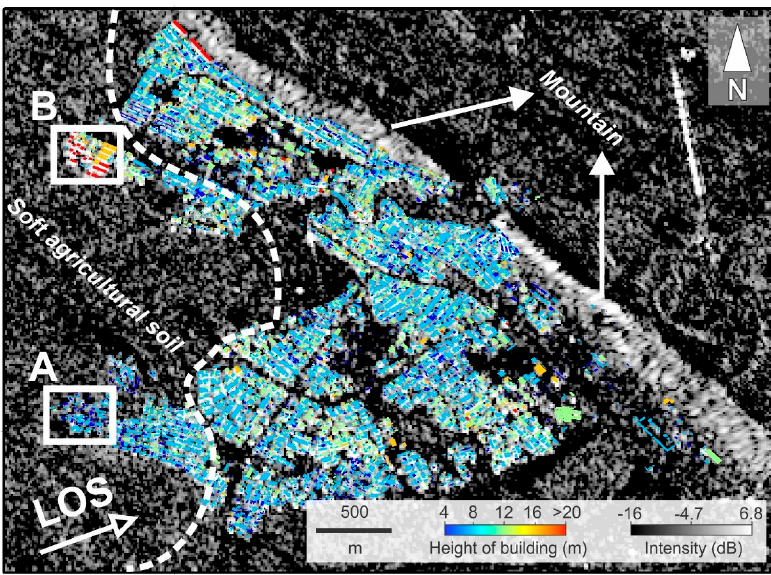
Figure 2. Heights of buildings with an accuracy of 0.5 m overlaid on the Sentinel-1 intensity image of Sarpole-Zahab acquired from an ascending orbit. The dashed line indicates the boundary of soft soil. Boxes A and B are the samples of new and old buildings, respectively, shown in Figure 4.